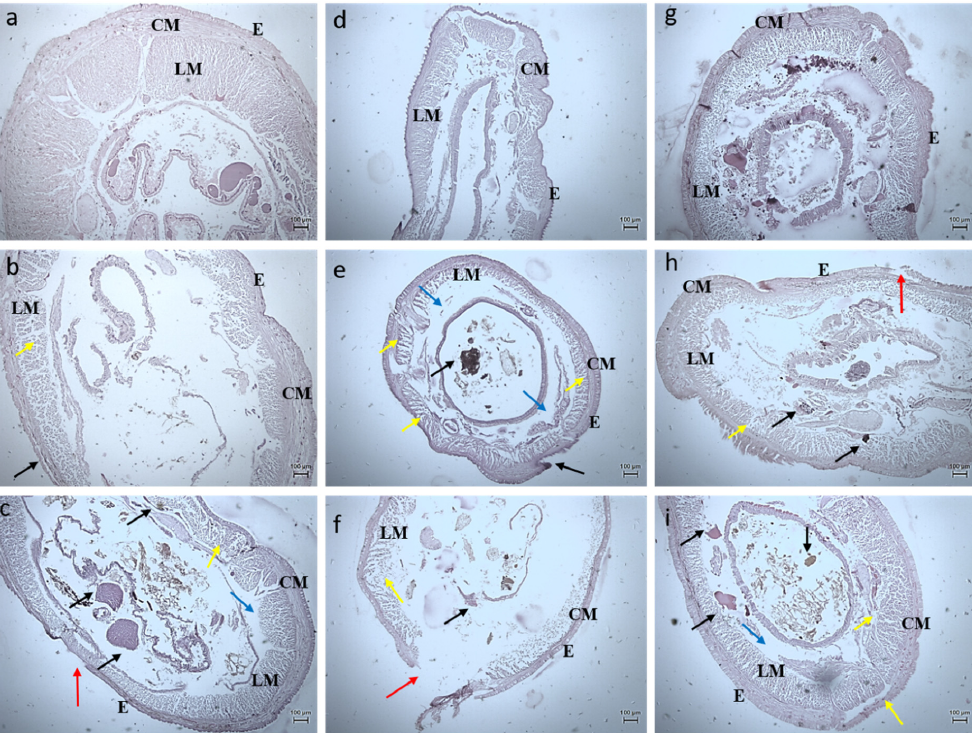
Figure 13. Histology images of hindgut region of earthworm— Eudrilus eugeniae (10X Magnification) ( a ) 10th day control, ( b ) exposed to 10 µg at 10th day, ( c ) exposed to 20 µg at 10th day; ( d ) 20th day control, ( e ) exposed to 10 µg at 20th day, ( f ) exposed to 20 µg at 20th day; ( g ) 30th day control, ( h ) exposed to 10 µg at 30th day, ( i ) exposed to 20 µg at 30th day. E—Epidermis, LM—Longitudinal Muscle, CM—Circular Muscle. Black arrow denotes lipofuscin, red arrow denotes erosion of epidermis, blue arrow denotes interstitial space, yellow arrow denotes fibrosis of CM.